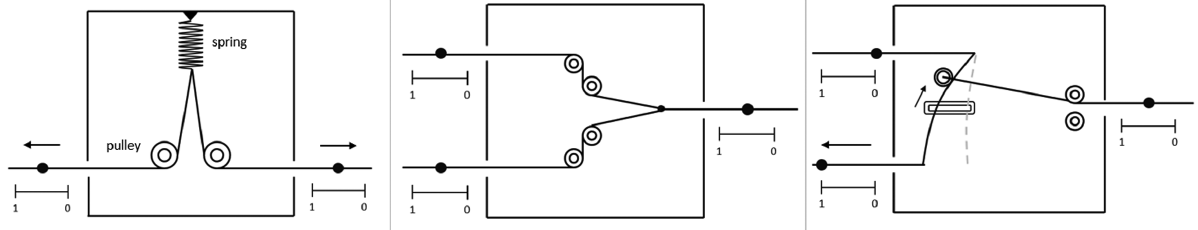
FIG. 2. Mechanical realization of, from left to right, NOT , OR , and AND logic gates